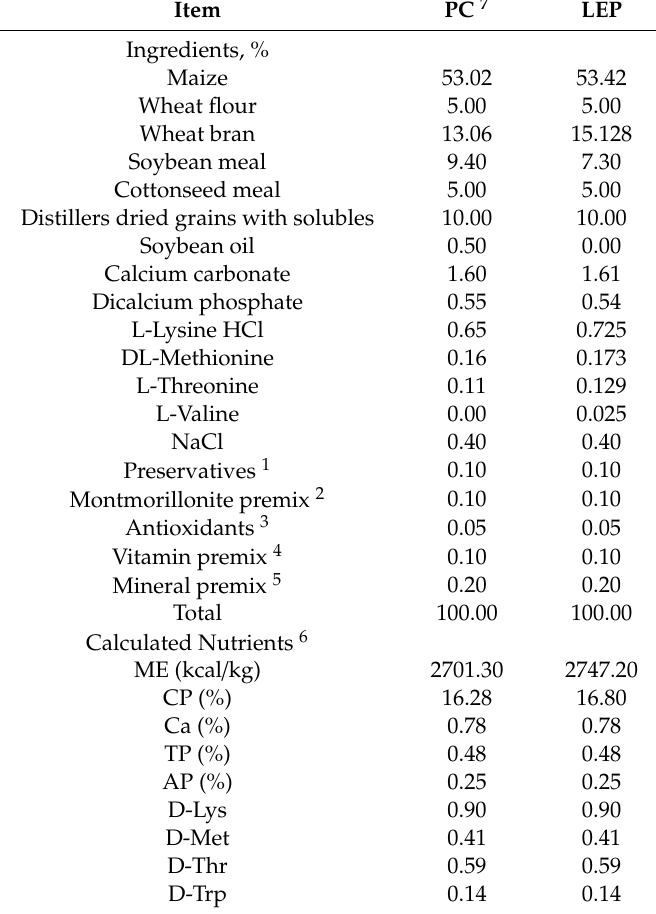
Table 2. Compositions and nutrient contents of the experiment basal diets (air dry basis, %, Experiment